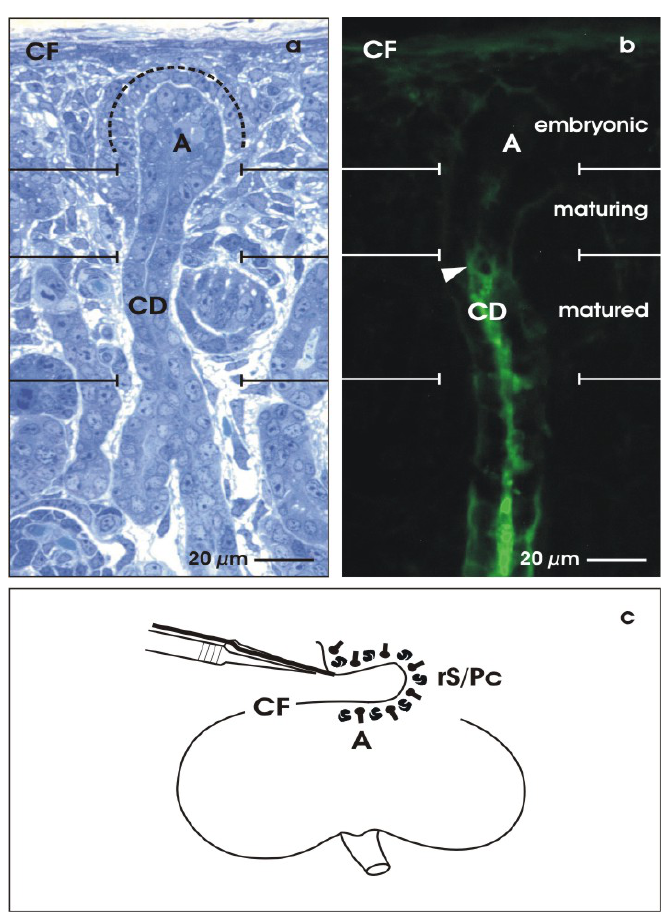
Except for PI 3-kinase and mTOR signaling pathways, the molecular mechanisms leading to different tubule segments are unknown [46]. Also, the preceding formation from the S-shaped body into spatially organized tubules is currently not understood. This step comprises the sprouting of cells to reach the necessary amount, the formation of a lumen and the extension of the individual